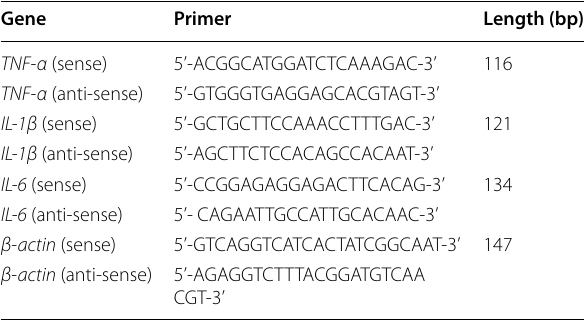
Table 1 Primer sequences specific for TNF-α, IL-6 and